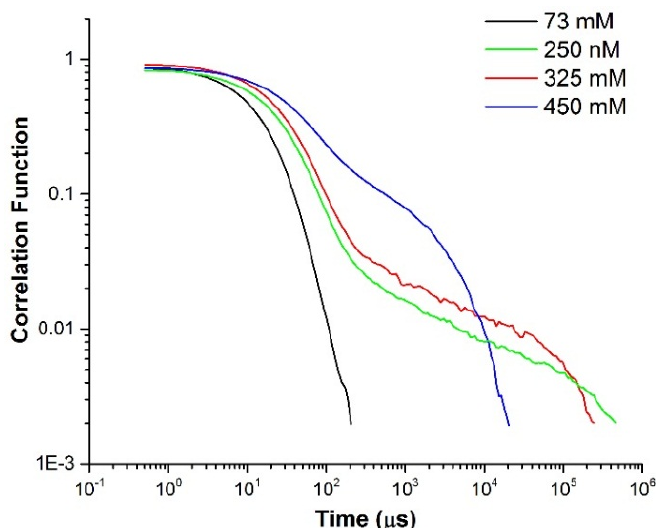
Figure 1. Correlograms illustrate a single decay mode during relaxation for the surfactant mixture of SLES : CapB (14% w/w : 2% w/w) containing 73 mM NaCl at 25 °C, while the other more viscous samples show a two-stage decay during